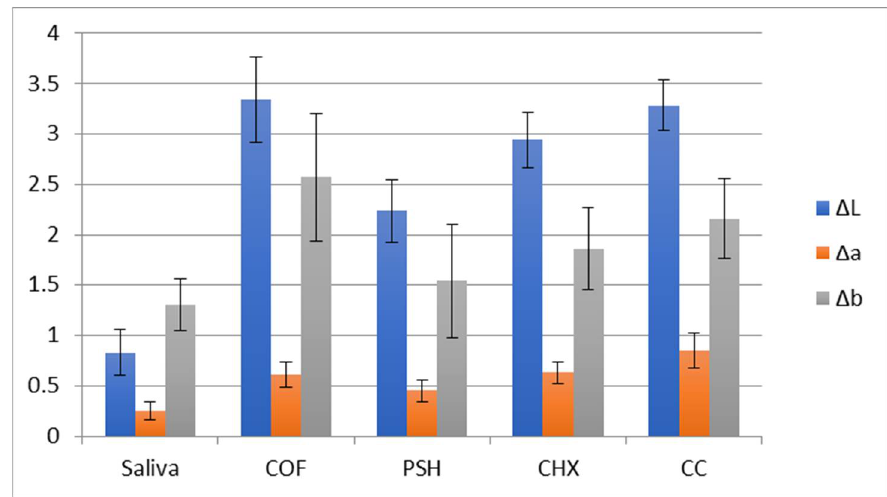
Figure 1. Mean and SD of ∆E values among the study groups. * Shows significantly different ∆E values compared to saliva; ^ shows significantly different ∆E values compared to coffee (COF).